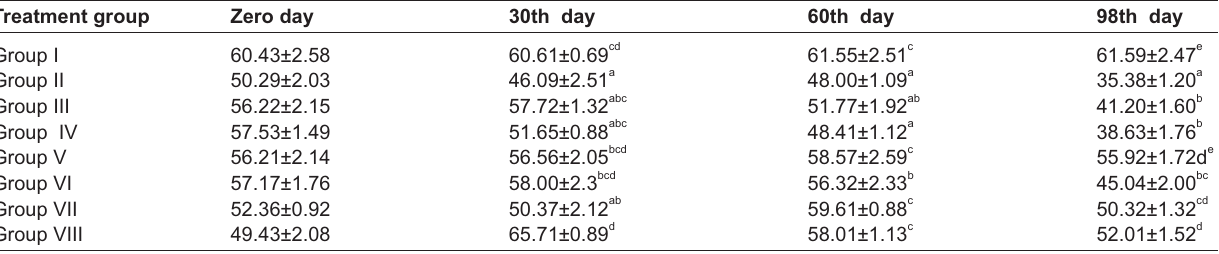
Table-3. Effect of oral administration of chlorpyriphos, lead acetate, vitamin C alone, and in combinations on blood superoxide dismutase activity (U/mg protein) in rats. Treatment group